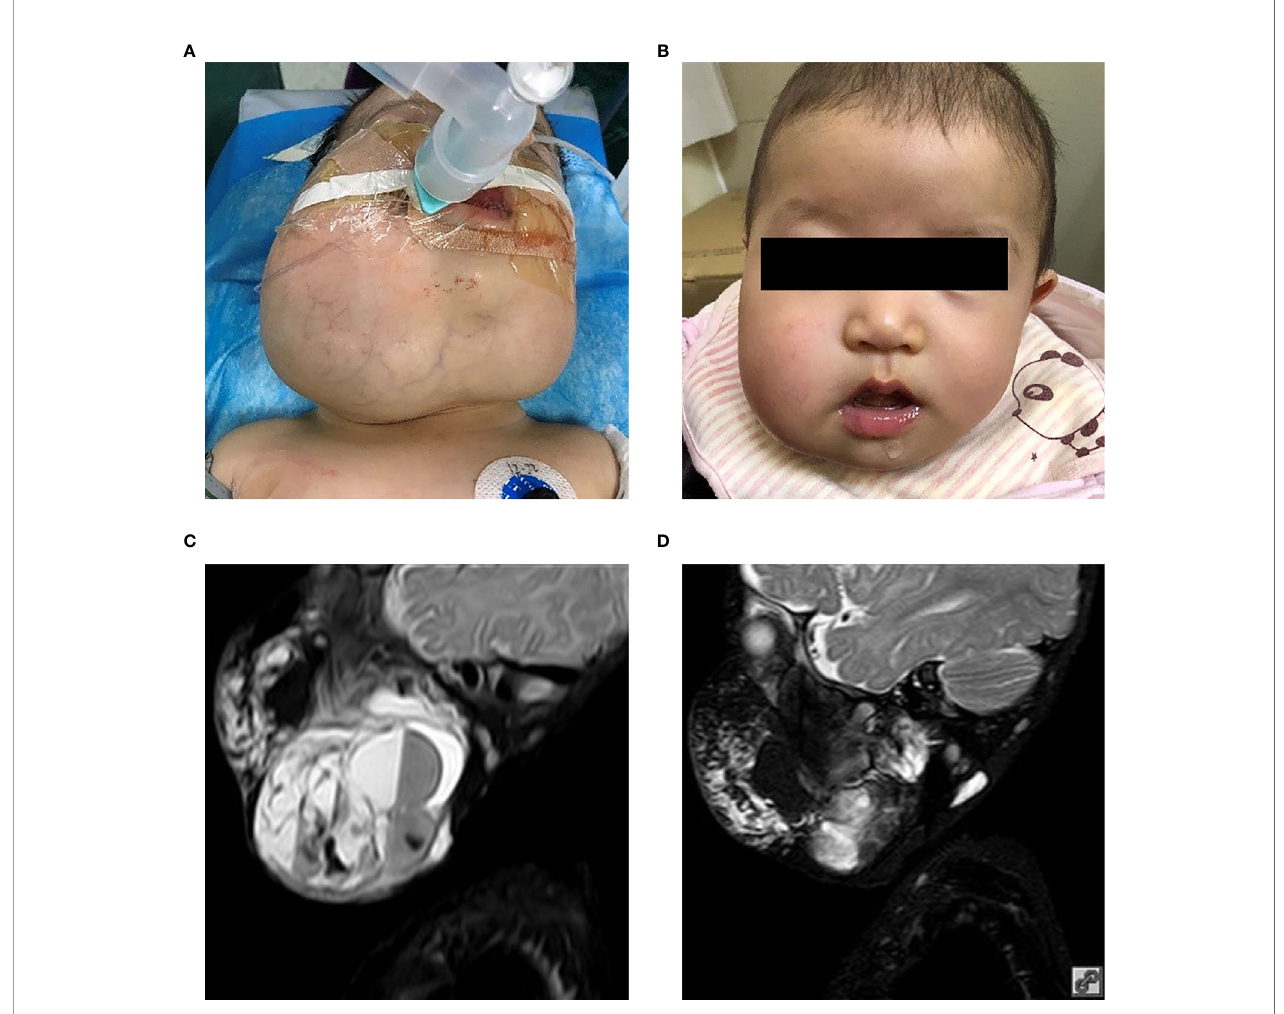
FIGURE 1 | Patient 2 from Table 1 . Extensive mixed, mostly macrocystic cervicofacial lymphatic malformations requiring intubation at birth. (A) Baseline after sclerotherapy, prior to initiation of sirolimus. (B) Five months on sirolimus. Sirolimus initiated at 5 months of age. T2 magnetic resonance imaging upon (C) initiation of sirolimus and (D) response after 5 months. T2, transverse